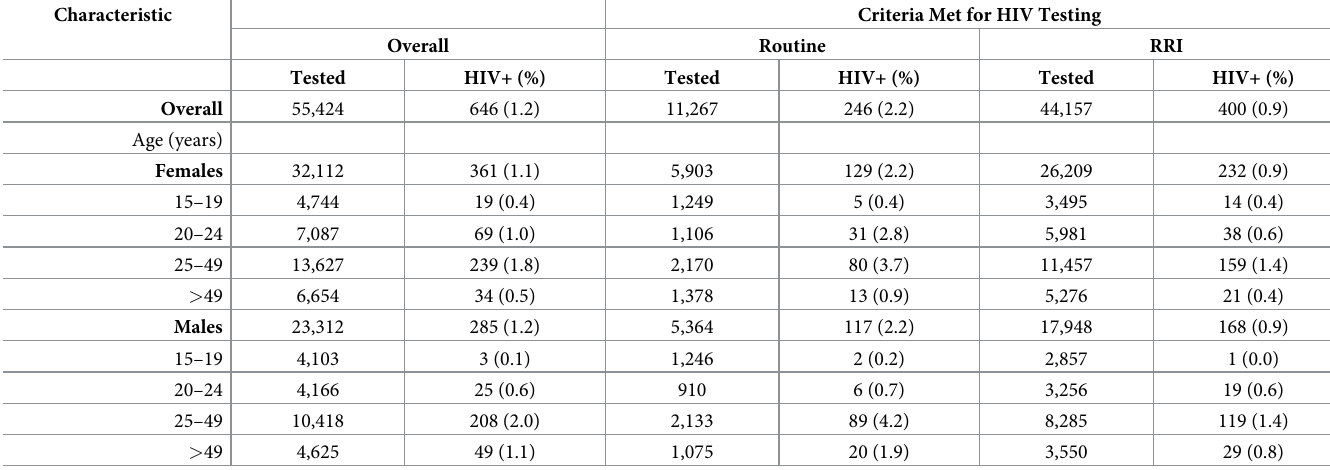
Table 4. Number and percent of patients with an HIV-positive test result by criteria met for testing, age and sex at selected facilities in Siaya, Kisumu and Homa Bay Counties, Kenya. Characteristic